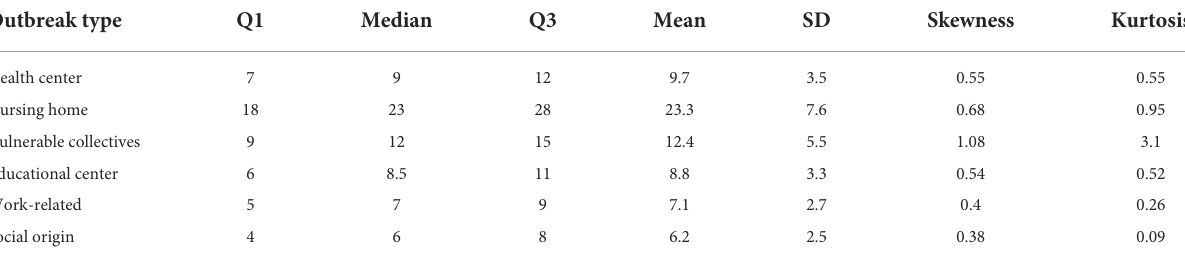
TABLE 2 Main characteristics of the distribution of the expected number of cases for each type of COVID-19 outbreak.